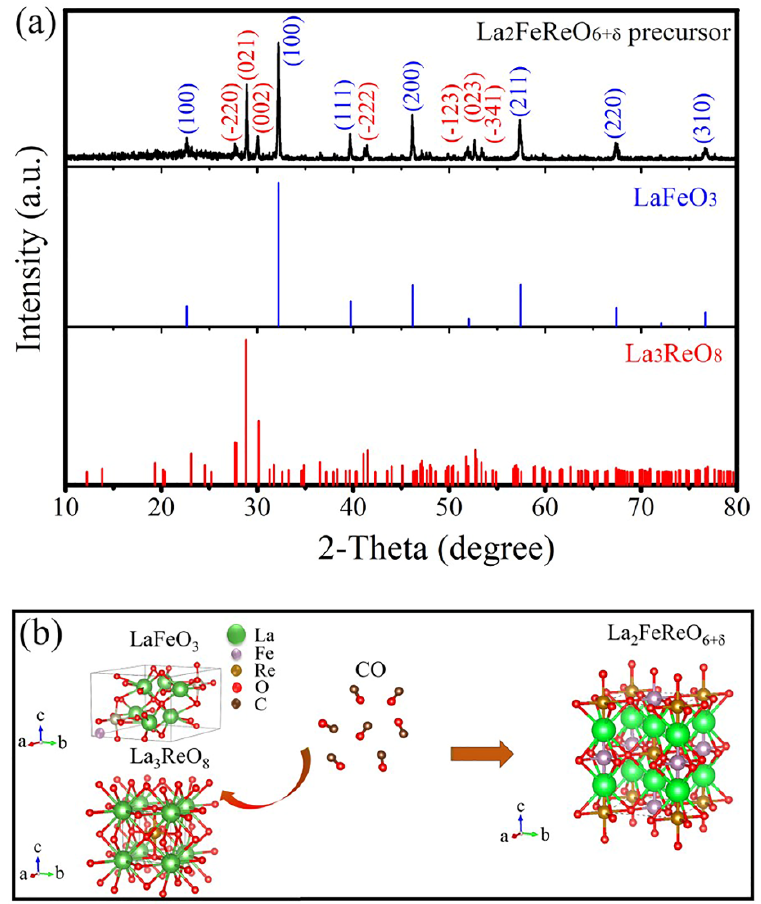
Figure 1. ( a ) XRD pattern of the obtained LFRO precursor. For comparison, XRD patterns of LaFeO 3 and La 3 ReO 8 are also presented. ( b ) Schematic diagram illustrating the reaction process of LFRO from the precursors of LaFeO 3 and La 3 ReO 8 .